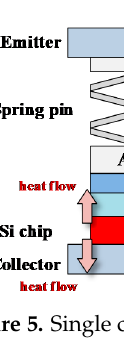
Table 1. Thermal conductivity of materials inside IGBT module.